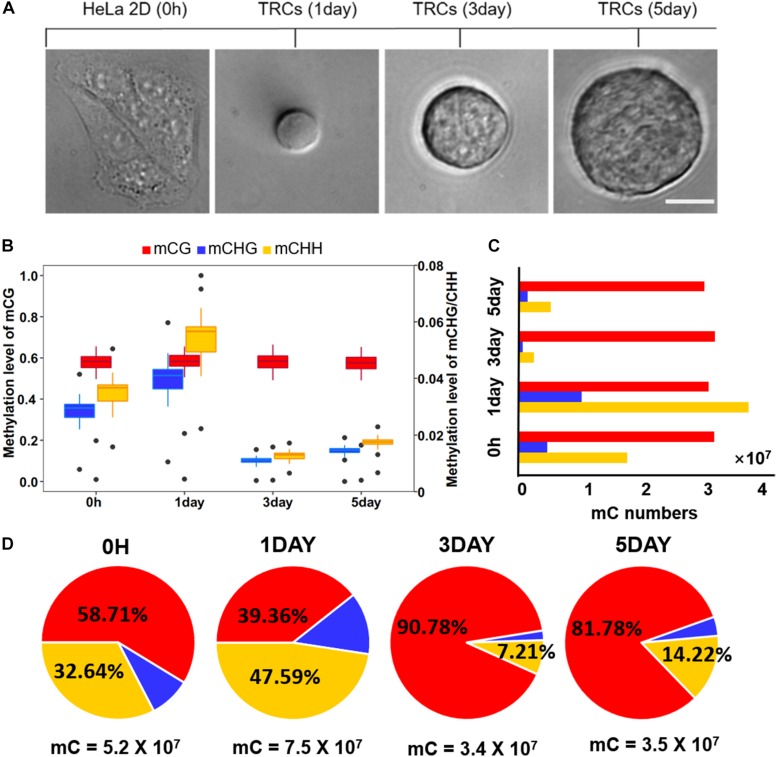
Global trends of DNA methylomes in different methylation types. (A) Representative images of 2D HeLa cells and multicellular tumor spheroid in 90 Pa soft fibrin gels from day 1 to day 5. Scale bar, 25 μm. (B) Box-plot shows the global distribution of methylation level (0–1) in each sequence context (mC in CG, CHG, CHH contexts) for all samples. The left y-axis indicates methylation level of mCG, while the right y axis represents methylation level of mCHG/mCHH. (C) Bar-plot shows the total numbers of mC in the CG, CHG, and CHH contexts. The methylated cytosines were counted on both strands. (D) The percentage of mC identified for all four samples in each sequence context. The total number of mCs for each sample is shown under the pie plot.